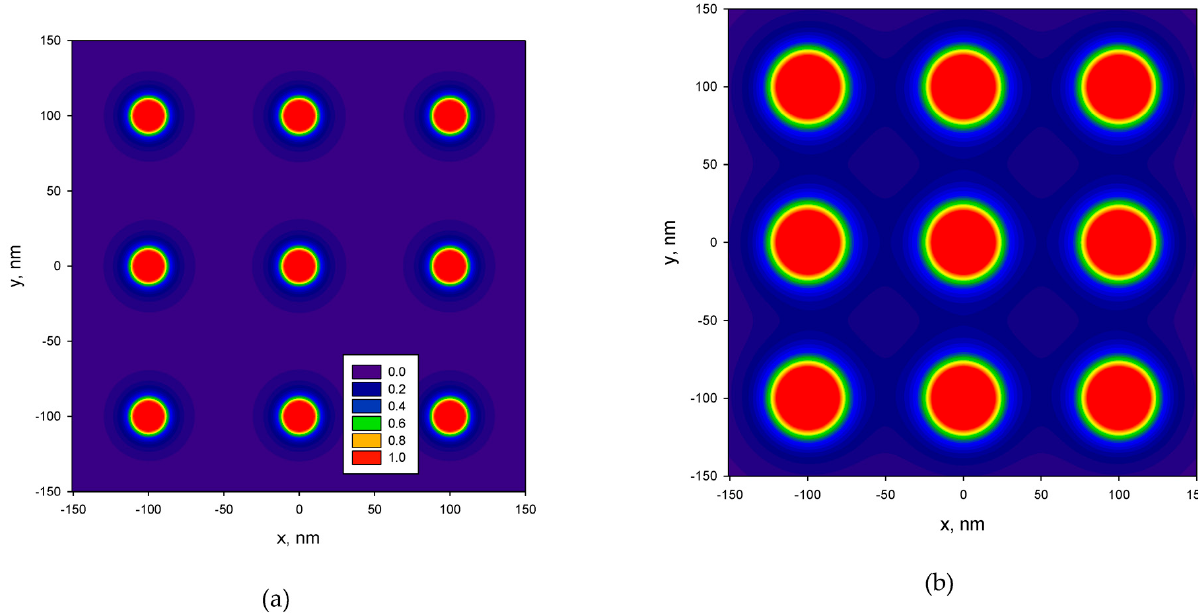
Figure 9. Dimensionless intensity of thermal stresses. Distance between hardening particles Λ p = 100 nm: ( a ) R p = 5 nm; ( b ) R p = 20